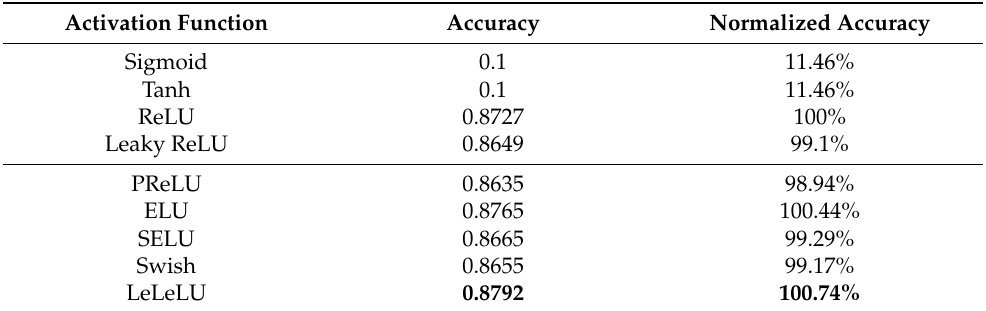
Table 5. Test accuracy in the CIFAR-10 dataset of the activation functions in question, using the VGG-16 neural network, and accuracy normalized to that attained by ReLU activation function.